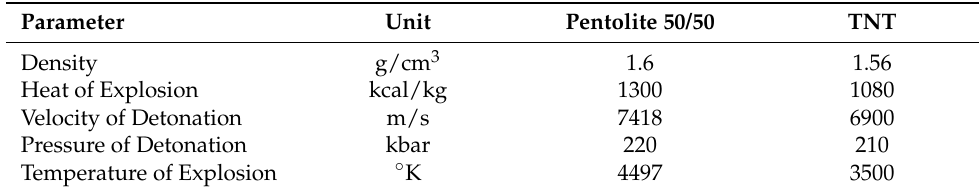
Table 1. Characteristics of the explosives